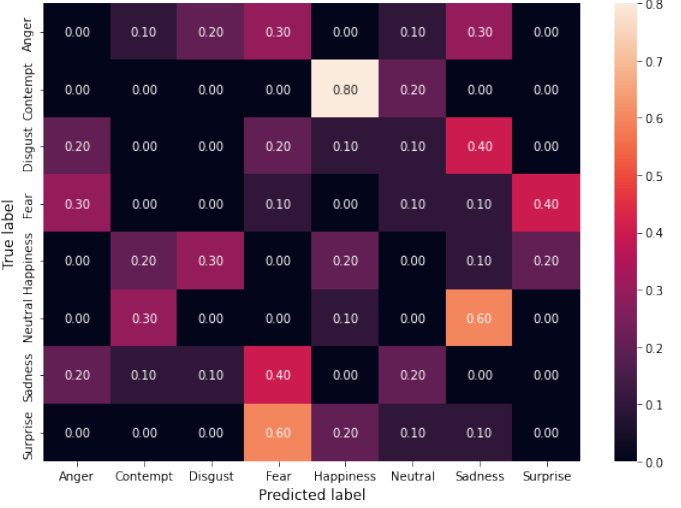
Figure 2. Confusion matrix from the results of the attack with four filters.